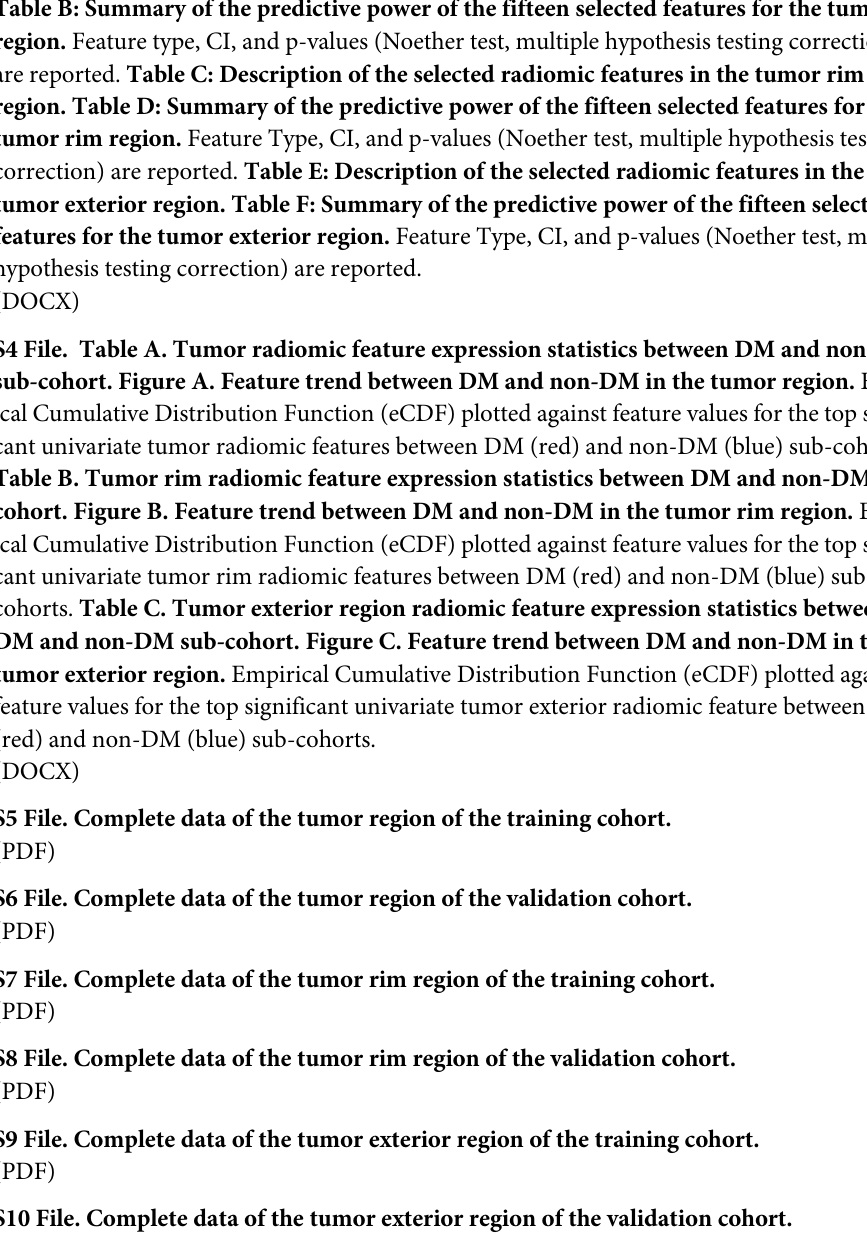
S3 File. Table A: Description of the selected radiomic features in the tumor region. Table B: Summary of the predictive power of the fifteen selected features for the tumor region. Feature type, CI, and p-values (Noether test, multiple hypothesis testing correction) are reported. Table C: Description of the selected radiomic features in the tumor rim region. Table D: Summary of the predictive power of the fifteen selected features for the tumor rim region. Feature Type, CI, and p-values (Noether test, multiple hypothesis testing correction) are reported. Table E: Description of the selected radiomic features in the tumor exterior region. Table F: Summary of the predictive power of the fifteen selected features for the tumor exterior region. Feature Type, CI, and p-values (Noether test, multiple hypothesis testing correction) are reported. S4 File. Table A. Tumor radiomic feature expression statistics between DM and non-DM sub-cohort. Figure A. Feature trend between DM and non-DM in the tumor region. Empir- ical Cumulative Distribution Function (eCDF) plotted against feature values for the top signifi- cant univariate tumor radiomic features between DM (red) and non-DM (blue) sub-cohorts. Table B. Tumor rim radiomic feature expression statistics between DM and non-DM sub- cohort. Figure B. Feature trend between DM and non-DM in the tumor rim region. Empir- ical Cumulative Distribution Function (eCDF) plotted against feature values for the top signifi- cant univariate tumor rim radiomic features between DM (red) and non-DM (blue) sub- cohorts. Table C. Tumor exterior region radiomic feature expression statistics between DM and non-DM sub-cohort. Figure C. Feature trend between DM and non-DM in the tumor exterior region. Empirical Cumulative Distribution Function (eCDF) plotted against feature values for the top significant univariate tumor exterior radiomic feature between DM (red) and non-DM (blue)